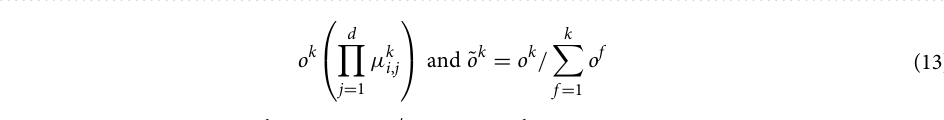
Figure 4. Visualization of Proposed Deep Fuzzy Convolutional Neural Network